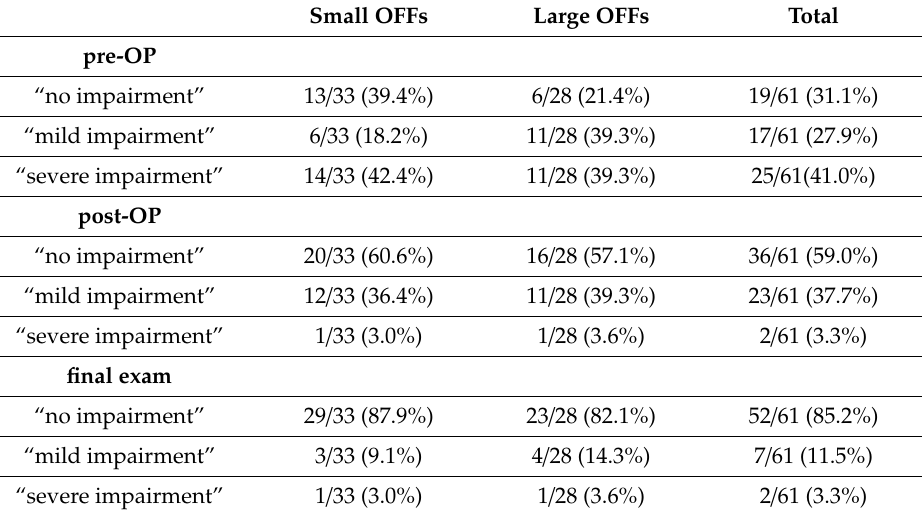
Figure 4. Stacked bar chart showing the results of orthoptic assessments at different timepoints. Table 4. Severity of pathological features in small and large OFFs pre- and postoperatively as well as on last follow-up examination.